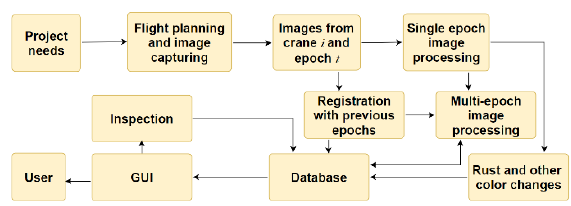
Figure 1. Overall concept of the project